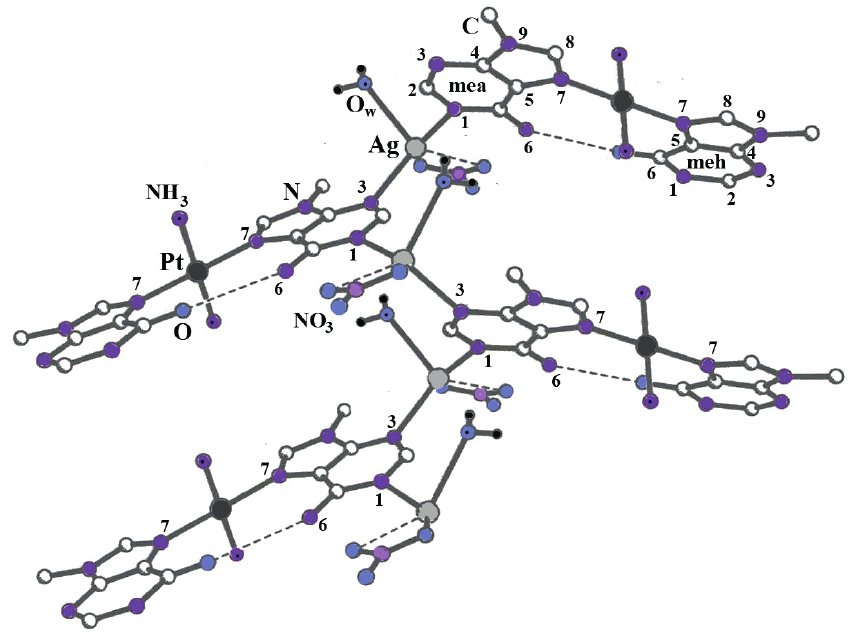
) Pt(µ-η 2 -meh)(µ-η 3 -Mea)Ag(NO) 3 2